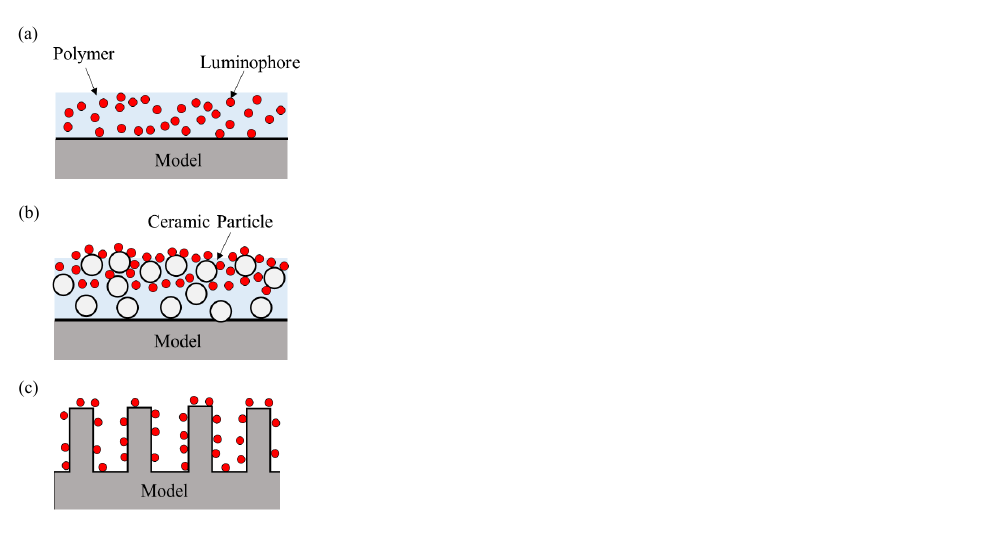
Figure 1. Schematic diagrams of the binder structure of ( a ) PHFIPM-PSP, ( b ) PC-PSP, and ( c ) AA-PSP. A schematic diagram of the calibration chamber is shown in Figure 2. The pressure in the calibration chamber was controlled using a pressure controller (DPI 515, Druck, Leicester, England). The temperature of the sample coupons was controlled using a temperature controller with a Peltier element (MT886-D1000, NetsuDenshi Kogyo, Tokyo, Japan ). The precision of the pressure and temperature controllers was 30 Pa and 0.05 K, respectively. For oxygen mole fractions other than 21%, a mixed gas cylinder with the given oxygen mole fraction (Taiyo Nippon Sanso Corporation, Tokyo, Japan) was used as the high-pressure source for the pressure controller. The oxygen mole fraction in these cylinders was guaranteed by the supplier. Compressed dry air was used for the oxygen mole fraction of 21%. The compositions of the gases in these cylinders are listed in Table 3. A 16-bit charge-coupled device (CCD) camera (ORCA II-BT1024, Hamamatsu Photonics, Shizuoka, Japan) with a camera lens (Nikkor 105 mm f/2.8, Nikon, Tokyo, Japan) was used as a photodetector. For PHFIPM-PSP and PC-PSP, an ultraviolet light-emitting diode (UV-LED; IL-106, Hardsoft, Kraków, Poland) with a center wavelength of 395 nm was used as the excitation light source, and an optical filter (650 ± 20 nm, PB0650/040, Asahi Spectra, Tokyo, Japan) was mounted in front of the camera lens. For AA-PSP, a blue LED (LEDA294-470) with a center wavelength of 470 nm was used as the excitation light source, and an optical filter (640 ± 50 nm, PB0640/100, Asahi Spectra, Tokyo, Japan) was mounted in front of the camera lens. The exposure time of the camera was set to achieve a PSP emission intensity of approximately 90% of the full-well capacity at the minimum ambient pressure for each oxygen mole fraction. One image was obtained in each case, and the emission intensity was averaged over at least 200 × 200 pixels except for the edges of the sample coupon. It should be noted that the pressure in the chamber and the temperature of the sample coupon were accurately controlled by the pressure and temperature controllers, respectively, and thus the variation in the time direction was